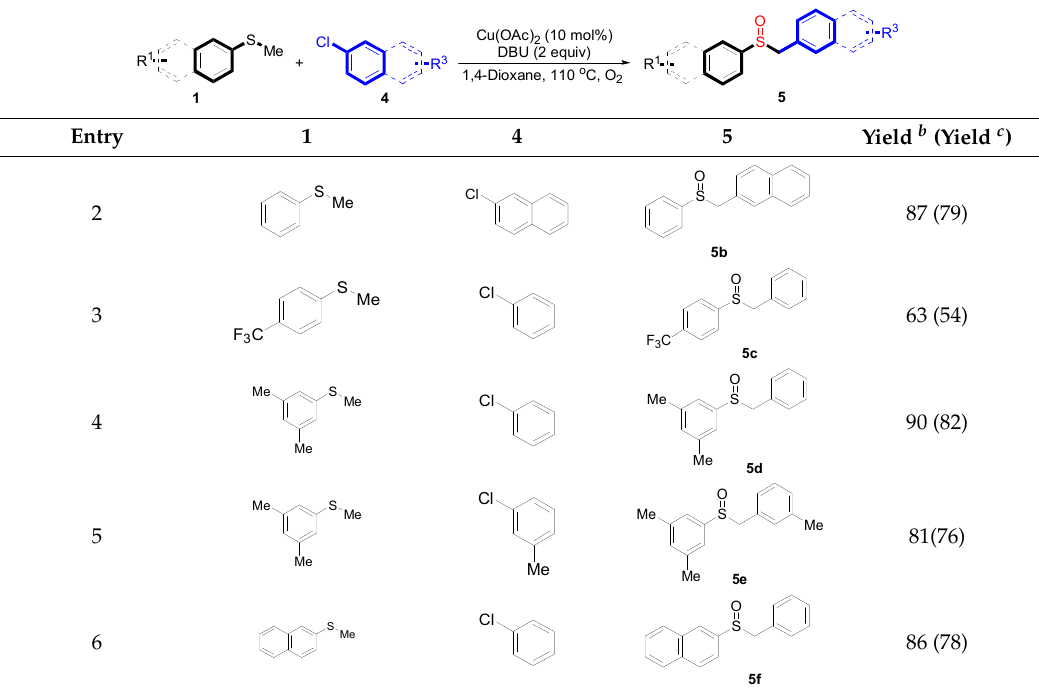
SO SO SO SO SO SO SO